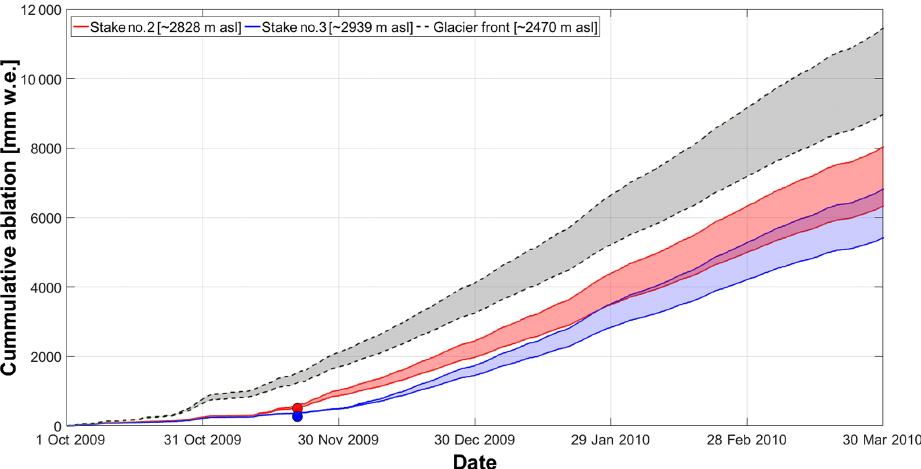
Figure 9. Total cumulative melt of Universidad Glacier using the degree-hour model. The red and blue lines and areas represent the cumula- tive melt at the locations of stakes 2 and 3, respectively. Points indicate the stake measurements. The area in grey enclosed by dashed black lines represents the lowest altitude of the